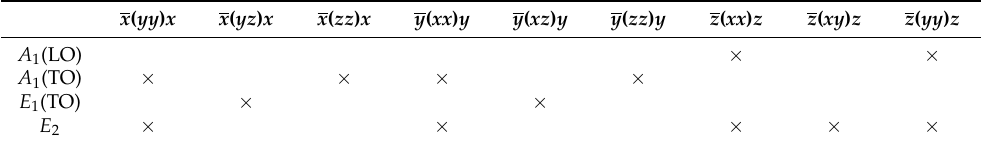
Table 3. The POLARIZATION SELECTION RULES [32–34] at the BCS for the Raman spectra of the bulk GaN (AlN) crystals. In the table, “ × ” represents the modes that can be observed in each one of the directions. In the first row, the experimental configuration in Porto’s notation is given.